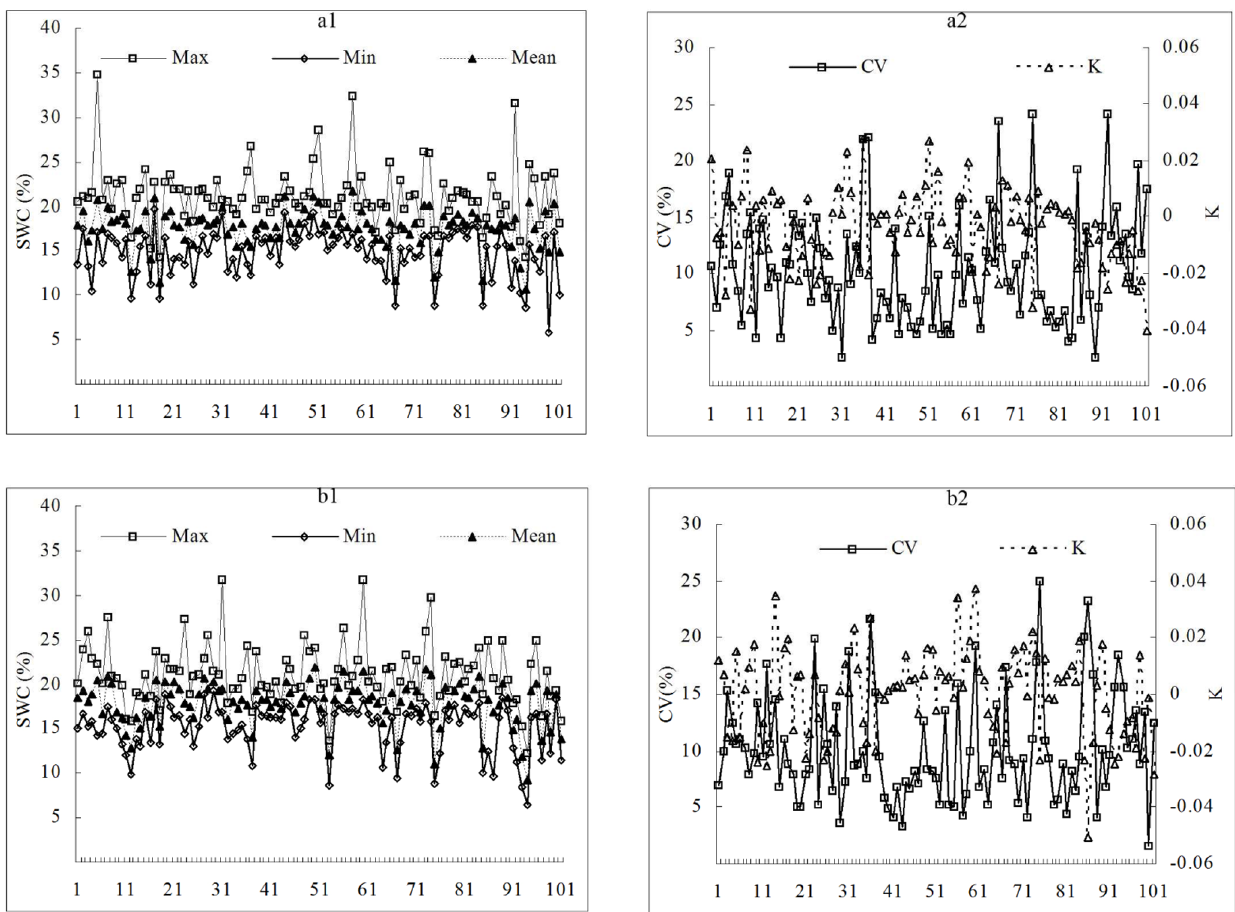
Figure 4. Statistical parameters of soil water content at 101 sampling points across the Sanyanjing catchment. (a. before the rainy season; and b. after the rainy season.)